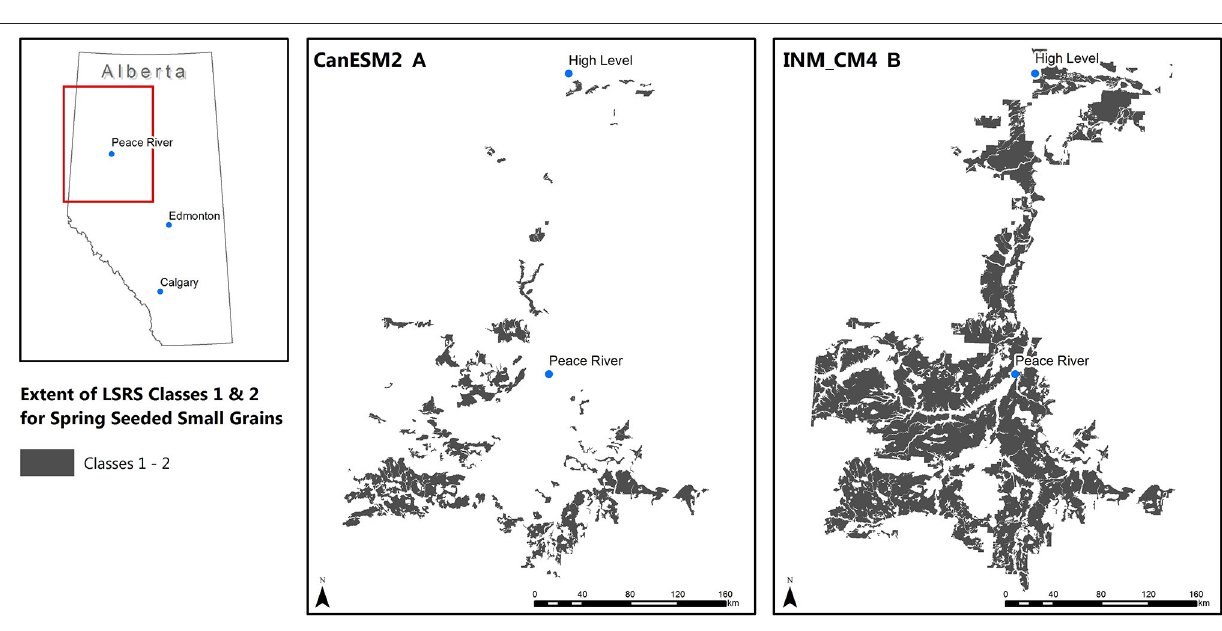
FIGURE 9 | Comparison of future prime land extents in the Peace River district of northwestern Alberta for the period 2041–2070. Shown are results based on climate outputs for RCP4.5 from the CanESM2 (A) and INM_CM4 (B) models intersected with 1:100,000 soil map polygons. The difference shown represents the degree of spatial uncertainty that exists with respect to future land suitability for grain production in the